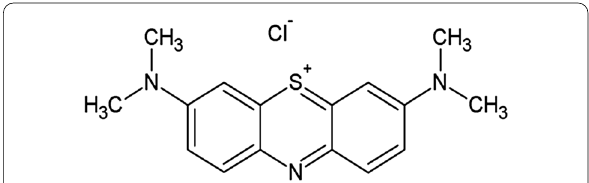
Fig. 1 Chemical structure of methylene blue